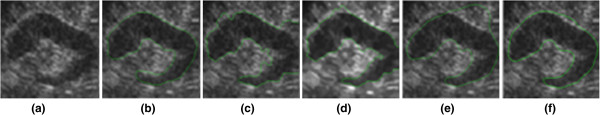
Qualitative segmentation results of four methods for kidney in US image. (a) original images; (b) manual segmentations (in green); (c) DRLSE method segmentations; (d) DRLSE segmentations on the NLTV denoised image; (e) the result of our method without using the alignment model after the segmentation; (f) the result of our method with using the alignment model after the segmentation.